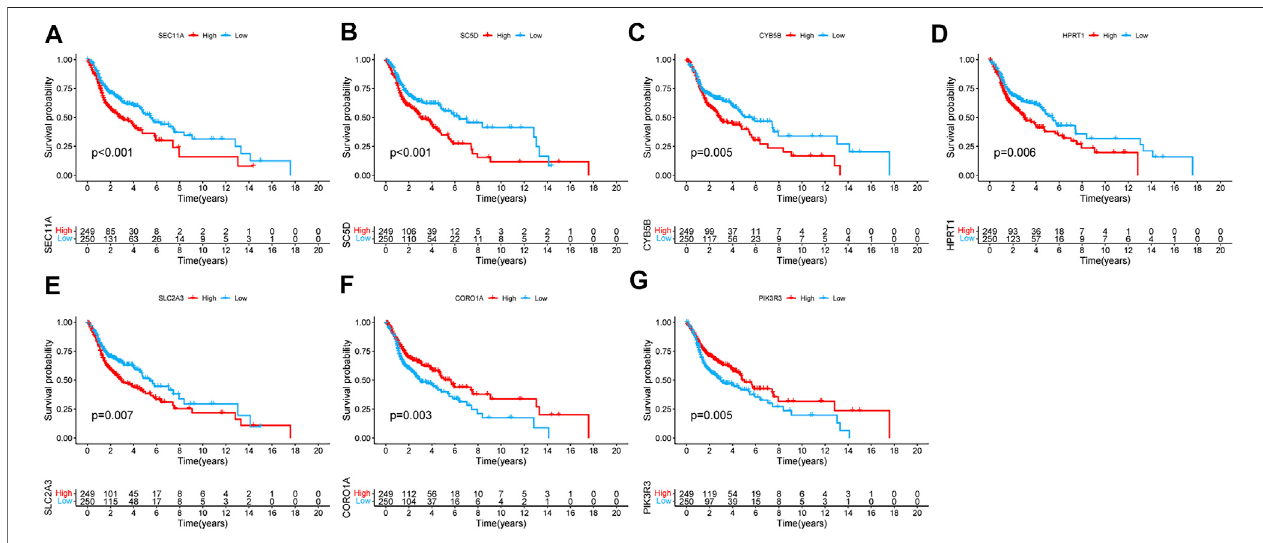
FIGURE5| Kaplan – MeiersurvivalanalysisofthesevengenesinTCGAcohort. (A) SEC11A, (B) SC5D, (C) CYB5B, (D) HPRT1, (E) SLC2A3, (F) CORO1A,and (G) PIK3R3.